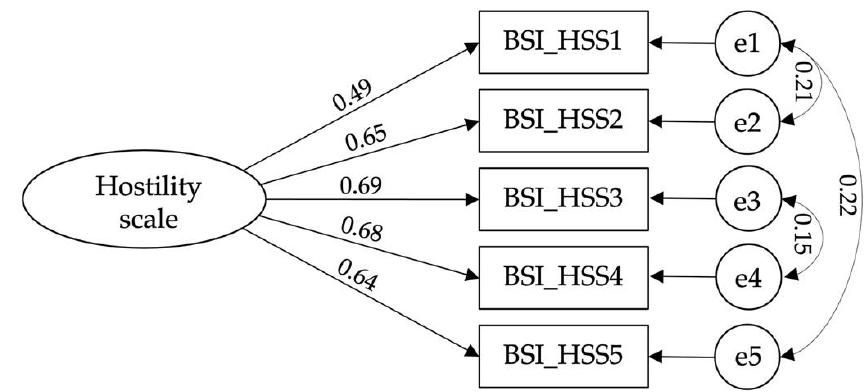
Figure 2. Model fit of Self-hatred Scale.